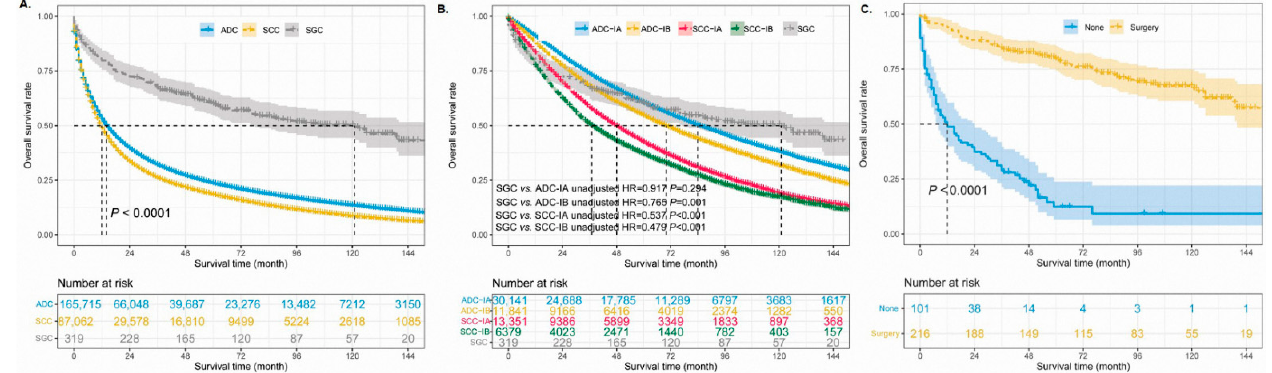
Figure 3. The unadjusted survival curves of different histological types ( A , B ). The unadjusted survival curves for SGC patients according to whether they received surgery ( C ). ADC: adenocarcinoma, SCC: squamous cell carcinoma, SGC: salivary gland-type carcinoma.